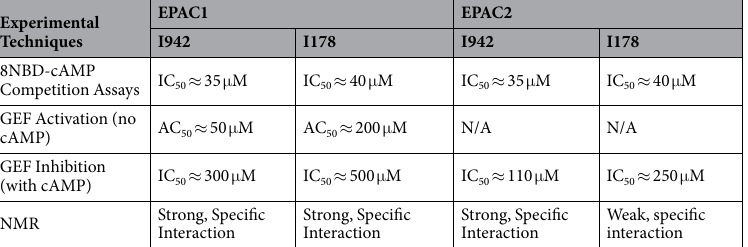
Table 1. Summary of I942 and I178 activities in vitro. The table shows the relative activities of I942 and I178 against EPAC1 and EPAC2 in NMR, CNBD binding assays (8NBD-cAMP Competition Assays) and in vitro GEF activity assays, in the presence or absence of cAMP. IC 50 refers to the ability of I942 and I178 to compete with 8NBD-cAMP binding to isolated CNBs or inhibit EPAC GEF activity in the presence of cAMP. AC 50 , refers to the ability of I942 and I178 to promote EPAC GEF activity in the absence of cAMP. N/A refers to the inability of I942 and I178 to promote GEF activity of